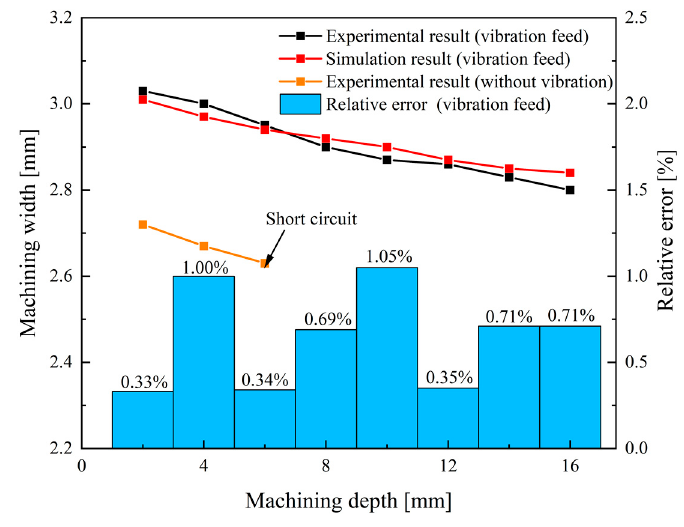
Figure 13. Variation of the channel width with different feed modes. Table 3. Evaluation of the machined channel width.